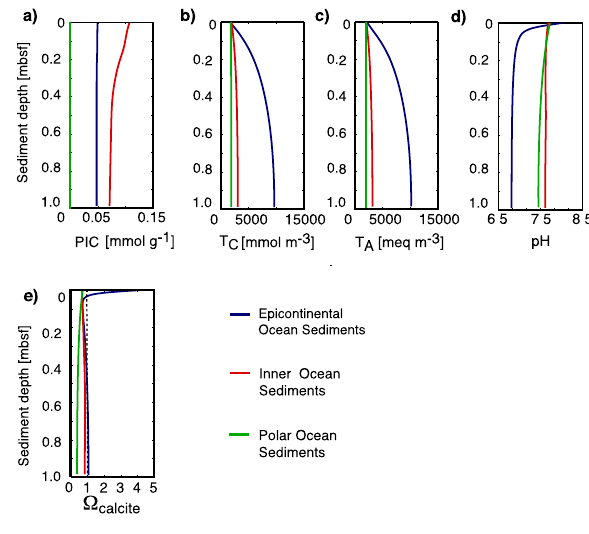
Fig. 10. Simulated steady state depth profile of (a) particulate inor- Figure 10: Simulated steady state depth profile of a) particulate inorganic carbon, b) total dissolved ganic carbon, (b) total dissolved carbon, (c) total alkalinity, (d) pH carbon, c) total alkalinity, d) pH and e) pore water saturation state with respect to calcite in and (e) pore water saturation state with respect to calcite in epicon- tinental, inner and polar ocean epicontinental, inner and polar ocean sediments.